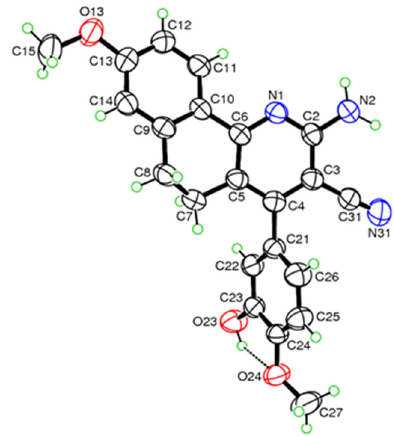
Figure 1. Molecular structure of compound 6 showing the atomic numbering. The displacement ellipsoids are drawn at 50% probability. A dashed line indicates an intramolecular hydrogen bond.